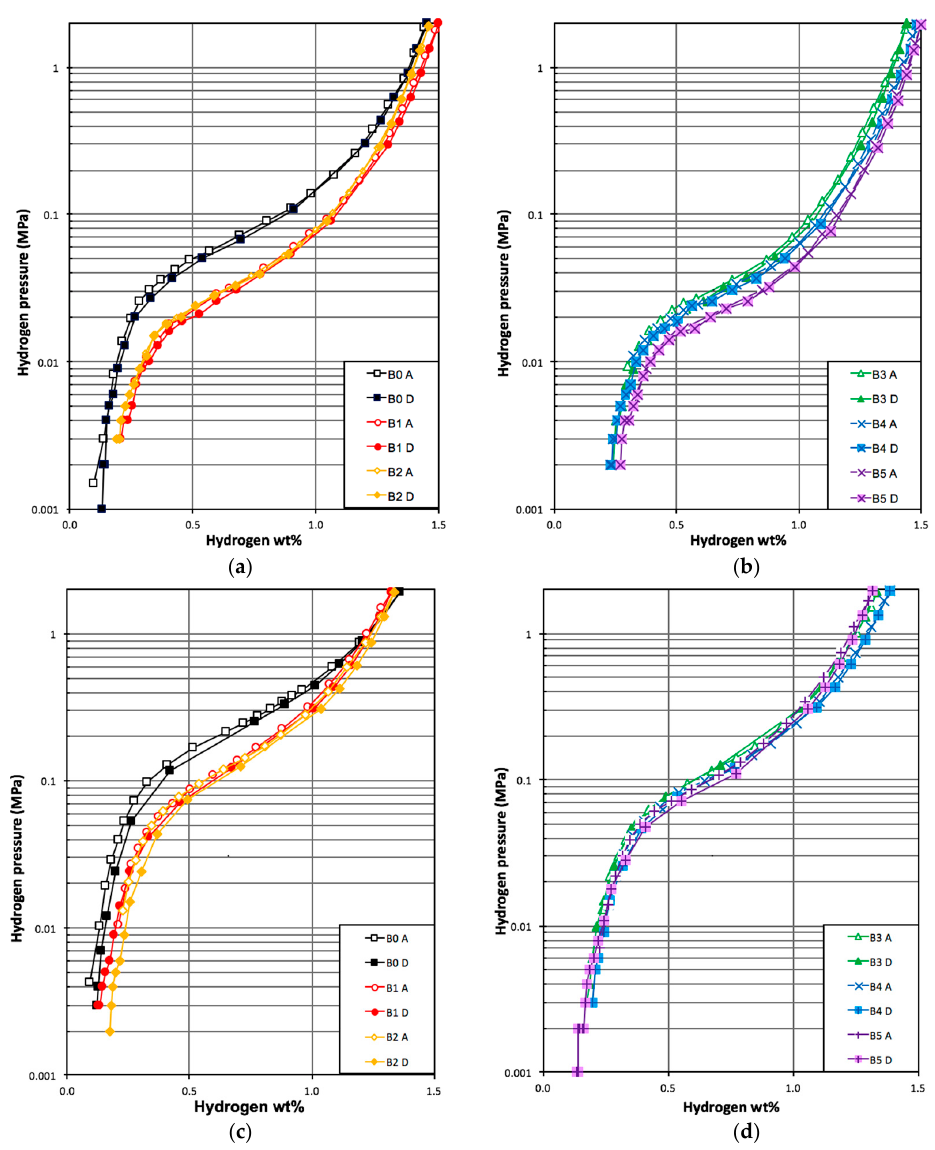
Figure 6. 30 °C PCT isotherms of alloys ( a ) B0, B1, and B2 and ( b ) B3, B4, and B5 and 60 °C PCT isotherms of alloys ( c ) B0, B1, and B2 and ( d ) B3, B4, and B5. Open and solid symbols are for absorption and desorption curves, respectively. Table 4. Summary of the gaseous phase properties.